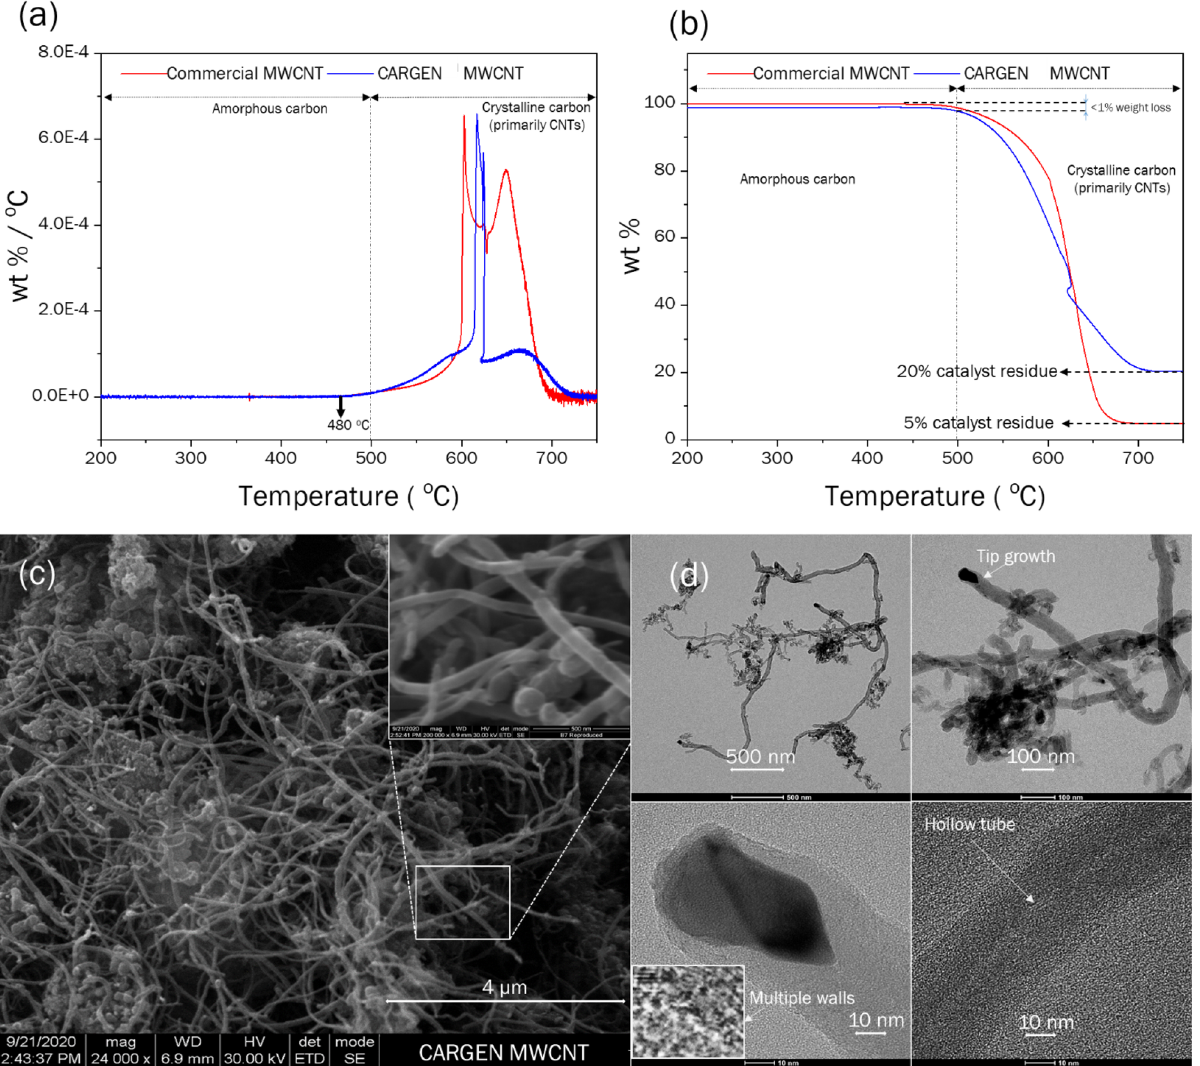
Figure 5. ( a ) Differential Thermogravimetric profiles of the MWCNTs produced from CARGEN and from commercial source, ( b ) Weight loss profiles of the commercial MWCNTs and the CARGEN produced MWCNTs, ( c ) SEM micrograph showing the length and diameter of the MWCNTs produced from CARGEN, ( d ) TEM images of the MWCNTs showing tip-growth mechanism and the multi-walled hollow characteristic of the as-produced MWCNTs from